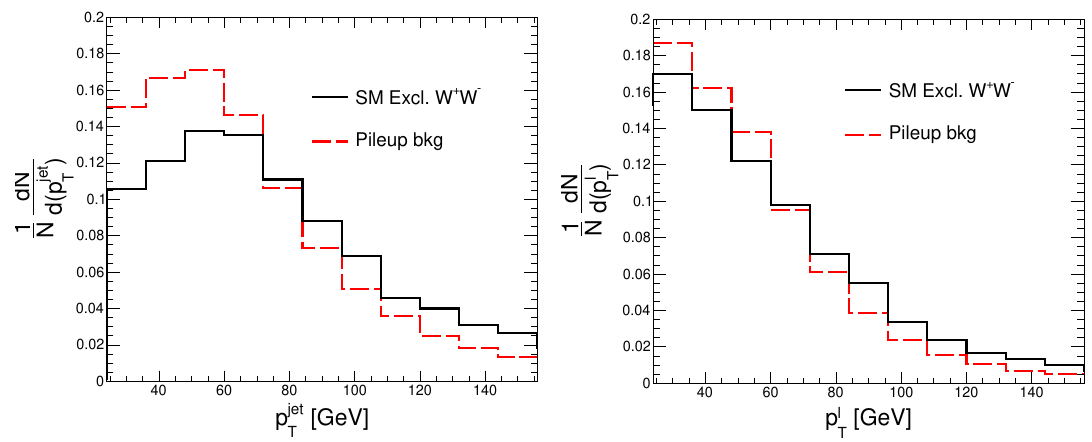
Figure 5 . Jet p T (left) and charged lepton p T (right) distributions normalized to unity for semi- leptonic SM exclusive W + W − production (black full line) and pileup background (red dashed line) after preselection